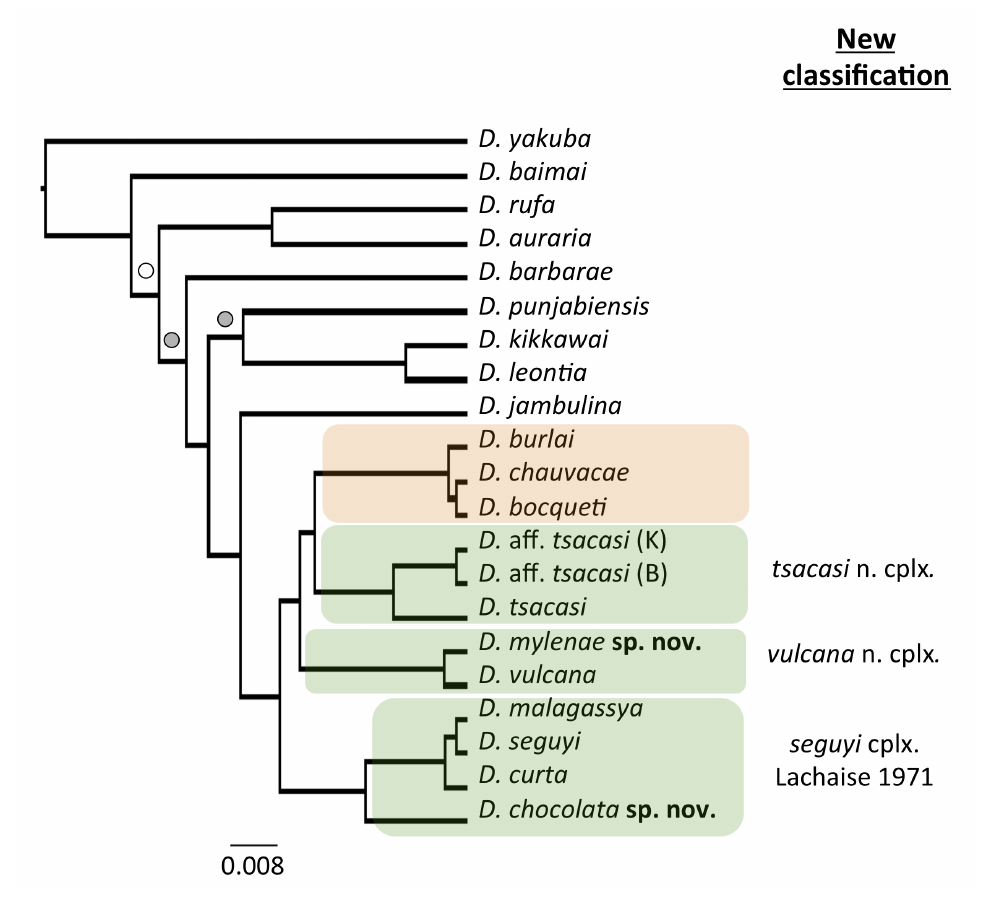
Fig. 1. Bayesian phylogeny of 19 species from the ‘ D. montium species group’ Da Lage, 2007 inferred from complete mitochondrial genomes. Nodes supported by 100% posterior probability (pp) are not labeled, those with pp > 90% or 60% are labeled with gray and white circles, respectively. Species belonging to the ‘ D. bocqueti species complex’ and the ‘ D. bakoue species complex’ are highlighted in orange and green, respectively. ‘K’ and ‘B’ refer to the strains of D. aff tsacasi Bock & Wheeler, 1972 from Kenya and Bioko Island,